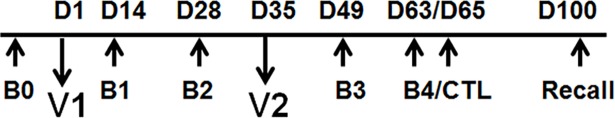
Timeline for immunization, serum and spleen collection.Vaccinations occurred on days 1 and 35, with serum collection on days 0, 28, 49 and 63. Spleen harvest for IFNγ and Granzyme B analysis occurred on days 65 and 100 post-primary vaccination.